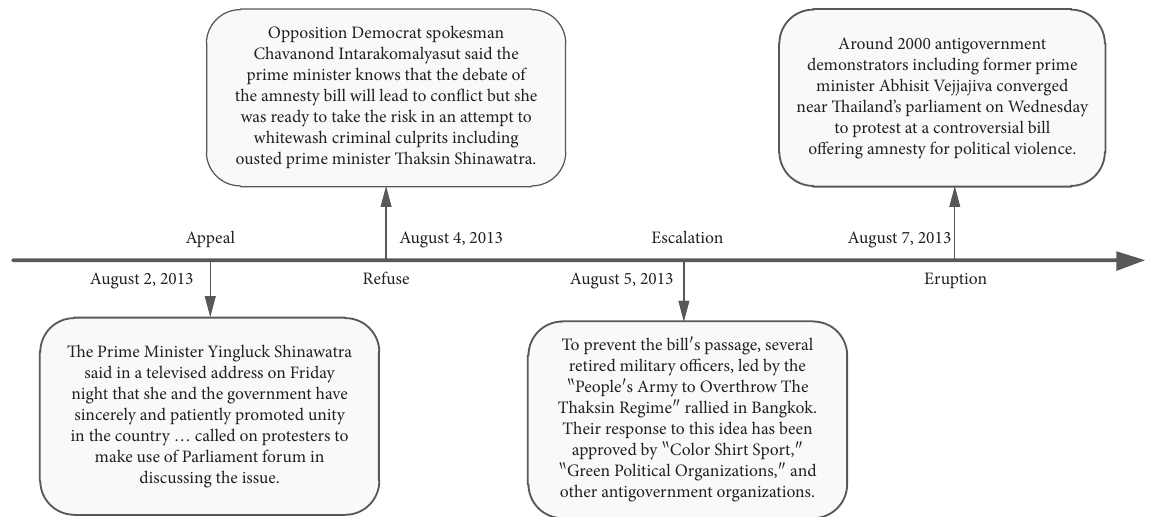
Figure 1: Event development stages before the protest against the amnesty bill on August 7, 2013, in Bangkok,